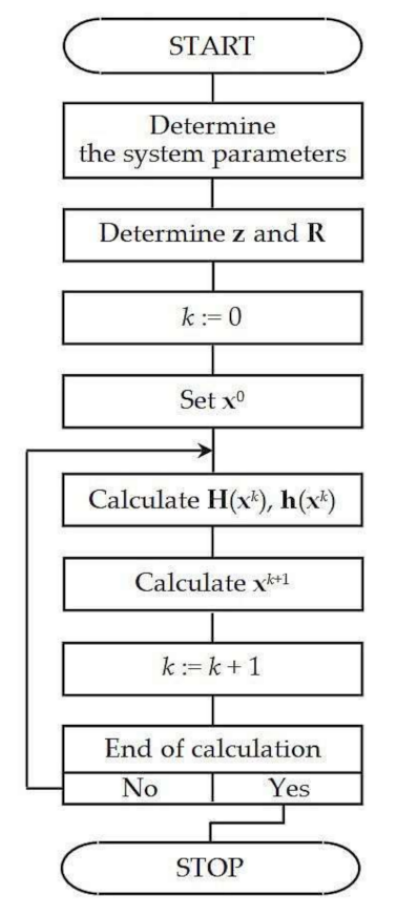
Figure 4. The flow chart of the state estimation